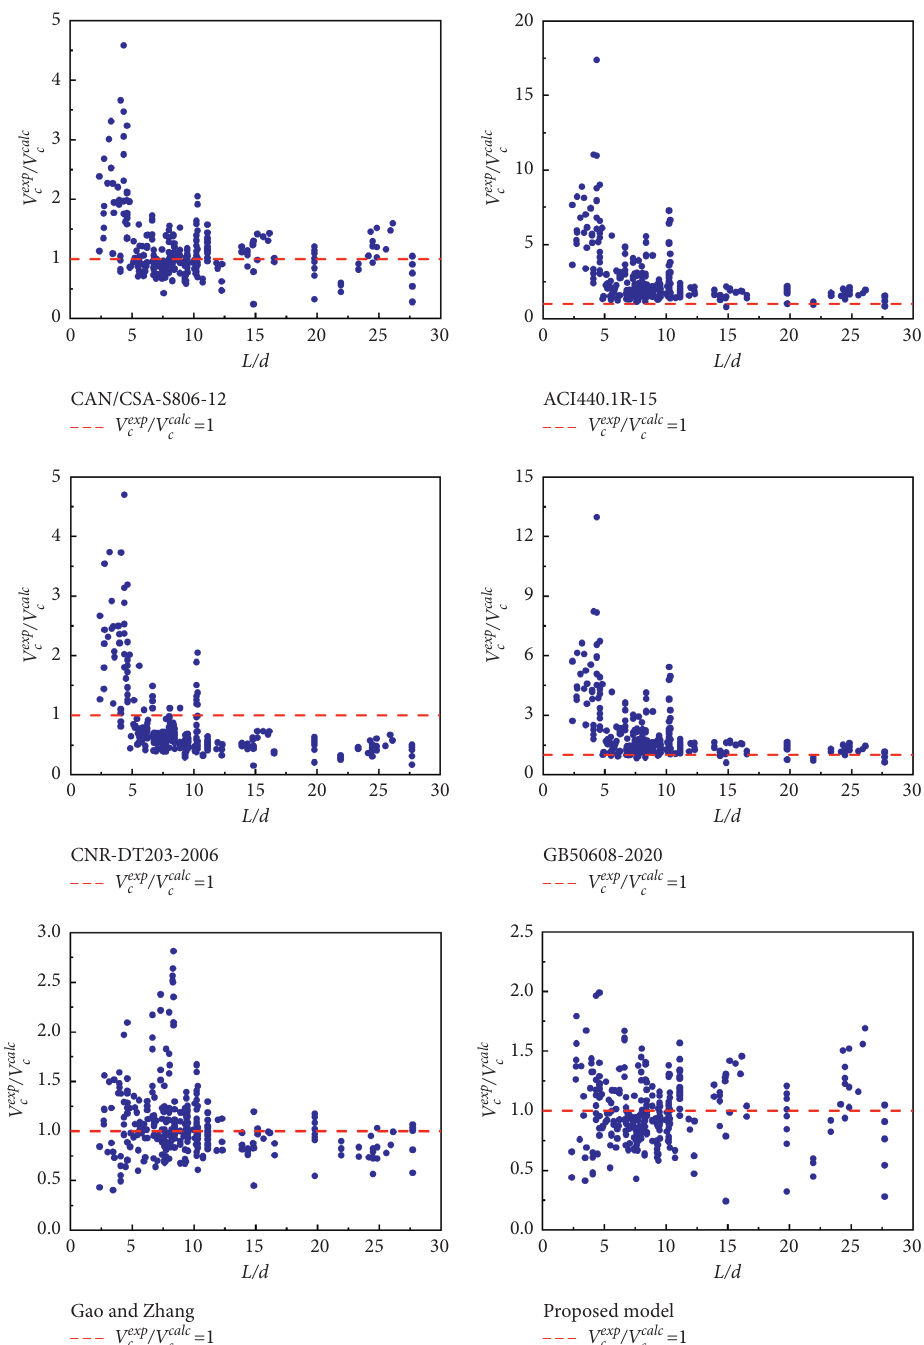
Figure 2: Relationship between V exp